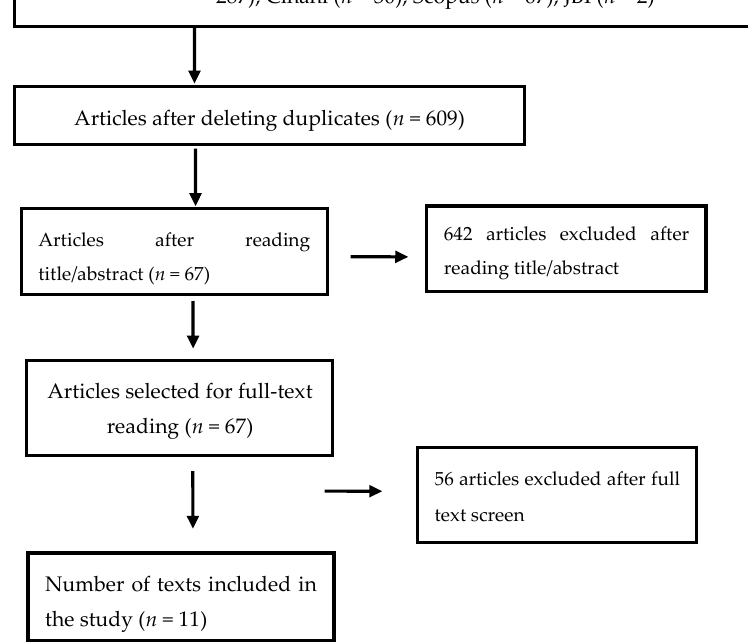
Figure 1. PRISMA flow diagram for study selection.